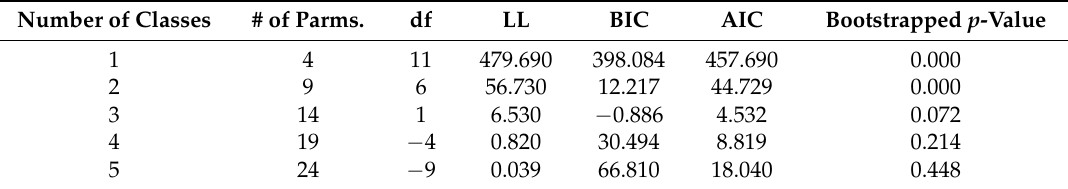
Table 2. Latent Class Model